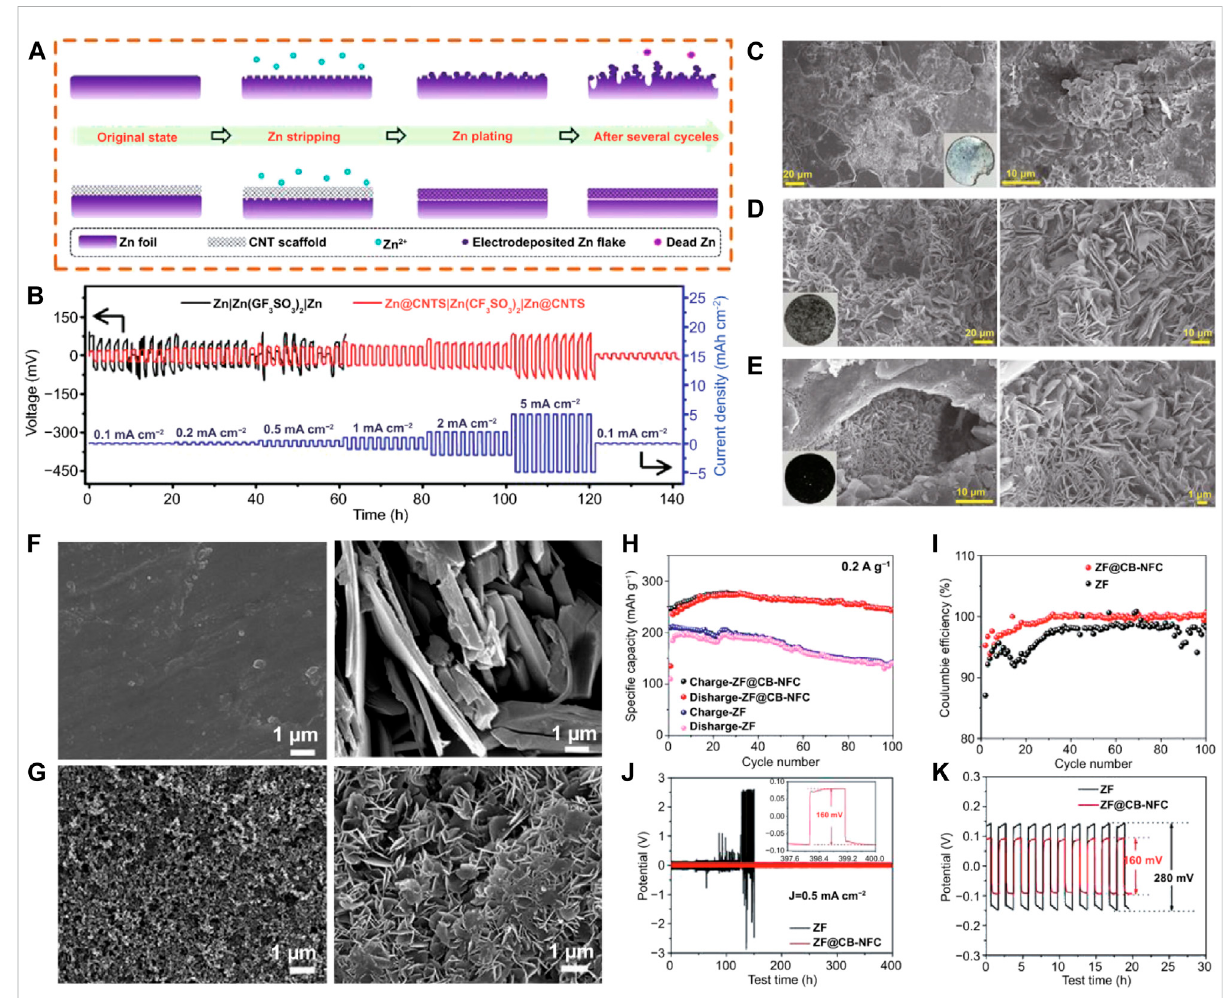
FIGURE 8 (A) Diagramsillustratingthestripping/platingbehaviorsofZnanodesstabilizedbyCNTscaffoldsandbareZFanodes. (B) Rateperformanceover a 1-h period at varying current densities of 0.1 – 5 mA · cm − 2 . (C) Symmetrical Zn||Zn cells ’ Zn electrodes as seen in a SEM picture. (D) SEM picture of symmetricalZn@CNTscellswithZnelectrodes. (E)